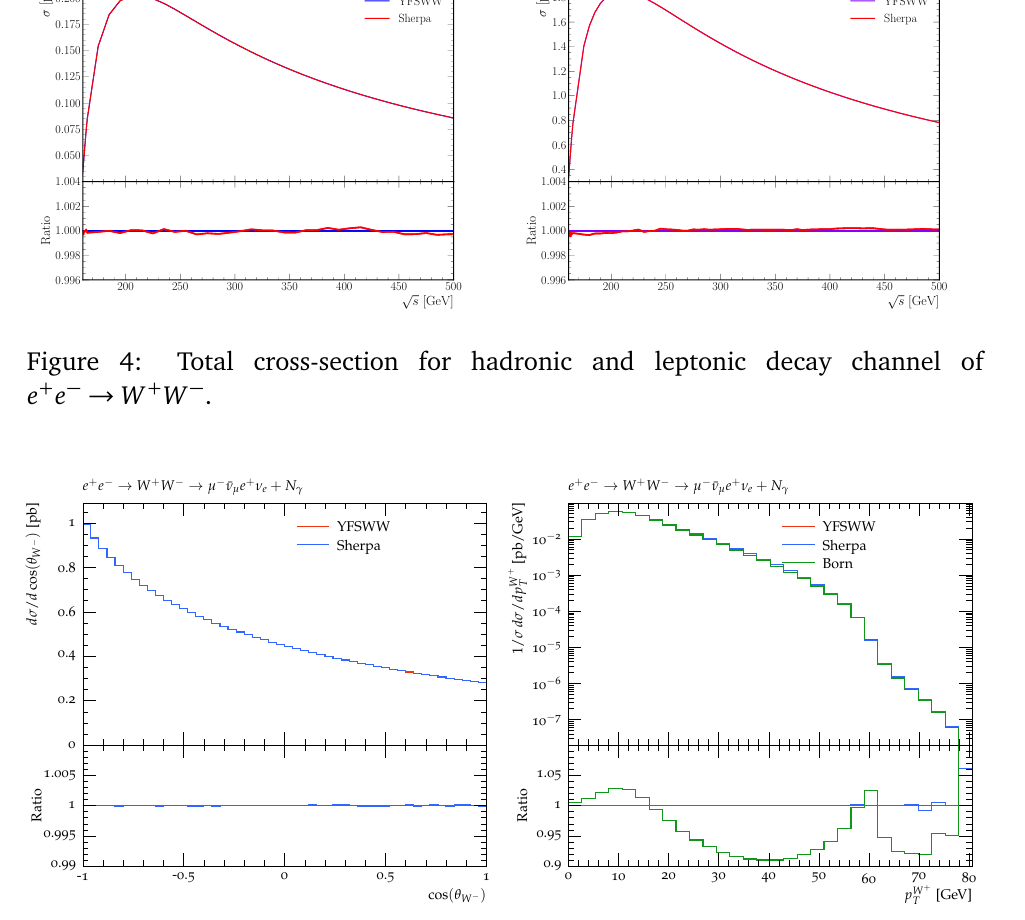
Figure 5: cos Θ of the W − boson with respect to the incoming e − beam (left), and W − the corresponding transverse momentum (right), comparing S HERPA with Y FS WW and the Born-level